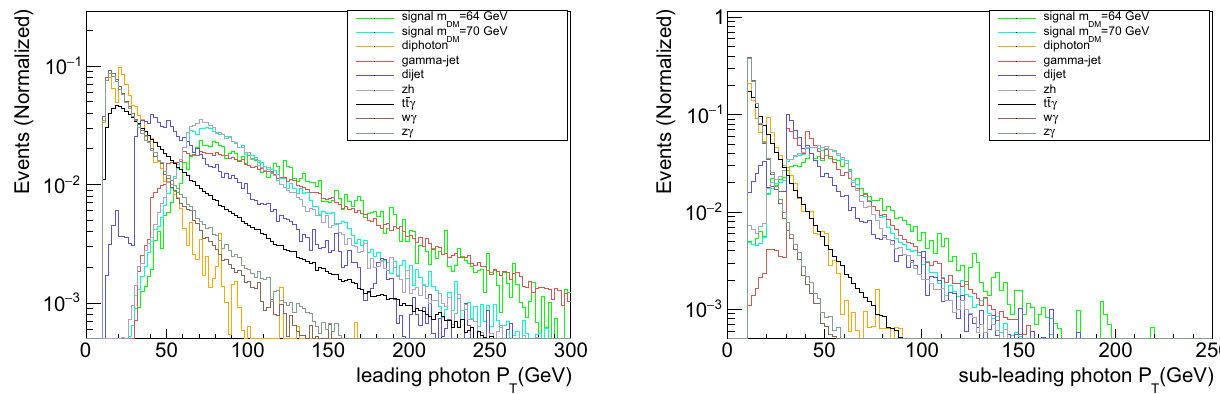
Fig. 8 Normalized distributions of transverse momenta of the leading (left) and sub-leading (right) photons